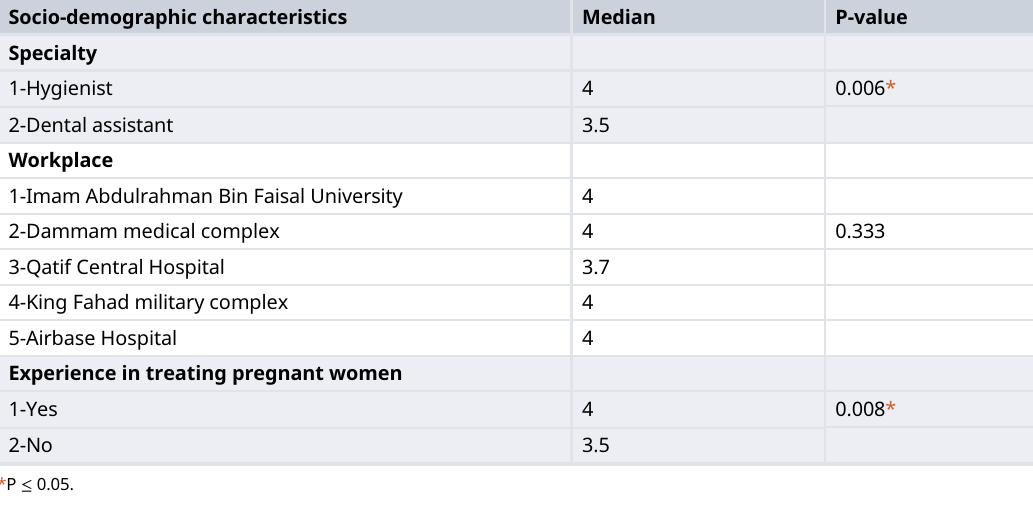
Table 4. Association of attitude with socio-demographics of dental auxiliaries